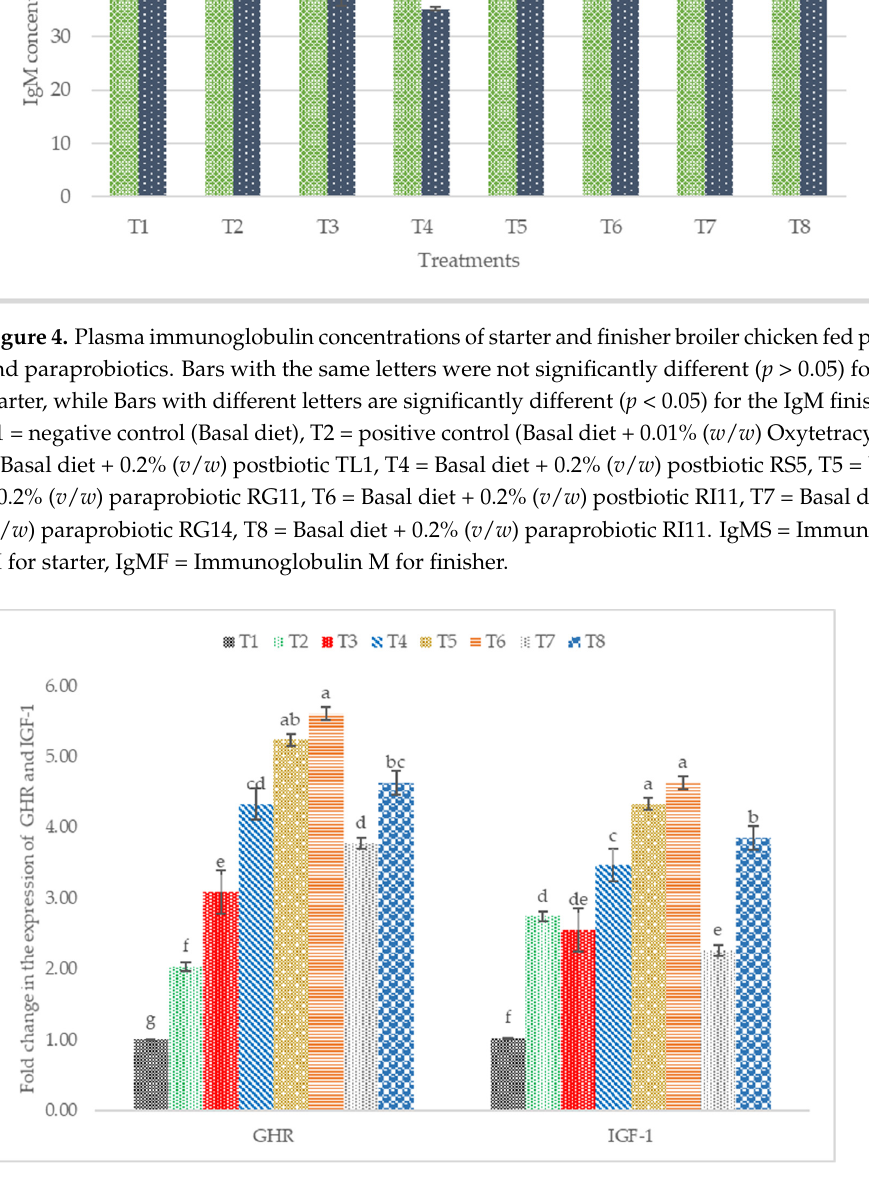
Figure 5. Hepatic GHR and IGF-1 mRNA expression level in broiler chickens fed postbiotics and paraprobiotics. Different letters on standard error bars indicate significant difference ( p < 0.05) for both GHR and IGF-1, n = 6. T1 = negative control (Basal diet), T2 = positive control (Basal diet + 0.01% ( w / w ) Oxytetracycline), T3 = Basal diet + 0.2% ( v / w ) postbiotic TL1, T4 = Basal diet + 0.2% ( v / w ) postbiotic RS5, T5 = Basal diet + 0.2% ( v / w ) paraprobiotic RG11, T6 = Basal diet + 0.2% ( v / w ) postbiotic RI11, T7 = Basal diet + 0.2% ( v / w ) paraprobiotic RG14, T8 = Basal diet + 0.2% ( v / w ) paraprobiotic RI11. GHR = Growth Hormone Receptor, IGF-1 = Insulin-like Growth Factor.